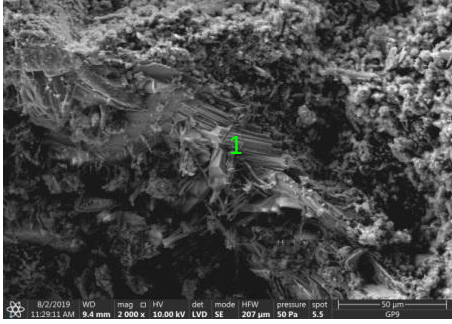
Figure 18. Microstructure of ZVIII mortar (FBC III) after 90 days of curing in seawater solution.